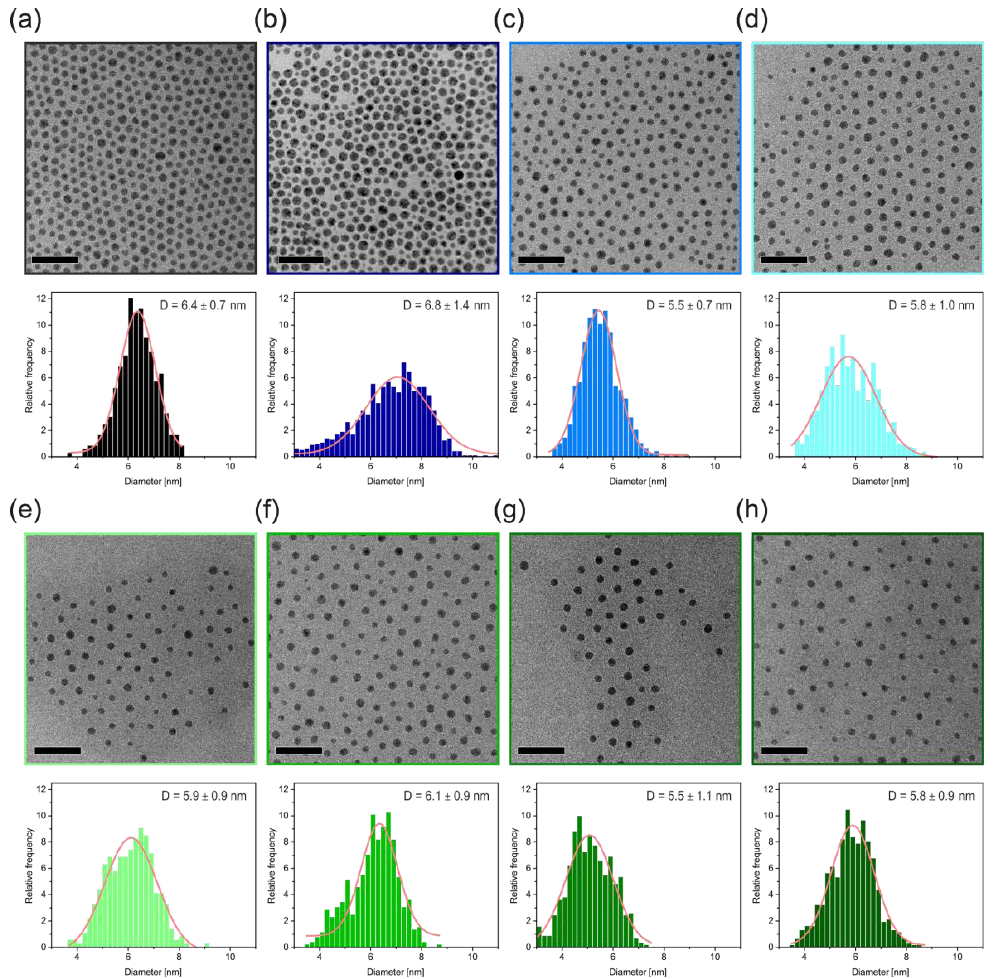
Figure 4. ( a ) Pure Ag@myristate nanoparticles. ( b – h ) nanocomposite samples with the following molecular weight of the polystyrene ligands: ( b ) 1 kg/mol; ( c ) 3 kg/mol; ( d ) 4 kg/mol; ( e ) 6 kg/mol; ( f ) 8 kg/mol; ( g ) 12 kg/mol; and ( h ) 18 kg/mol. The interparticle distance increases with increasing molecular weight. All scale bars are 50 nm. The histograms in the bottom panel show the size distributions of the Ag core diameter of the respective sample.